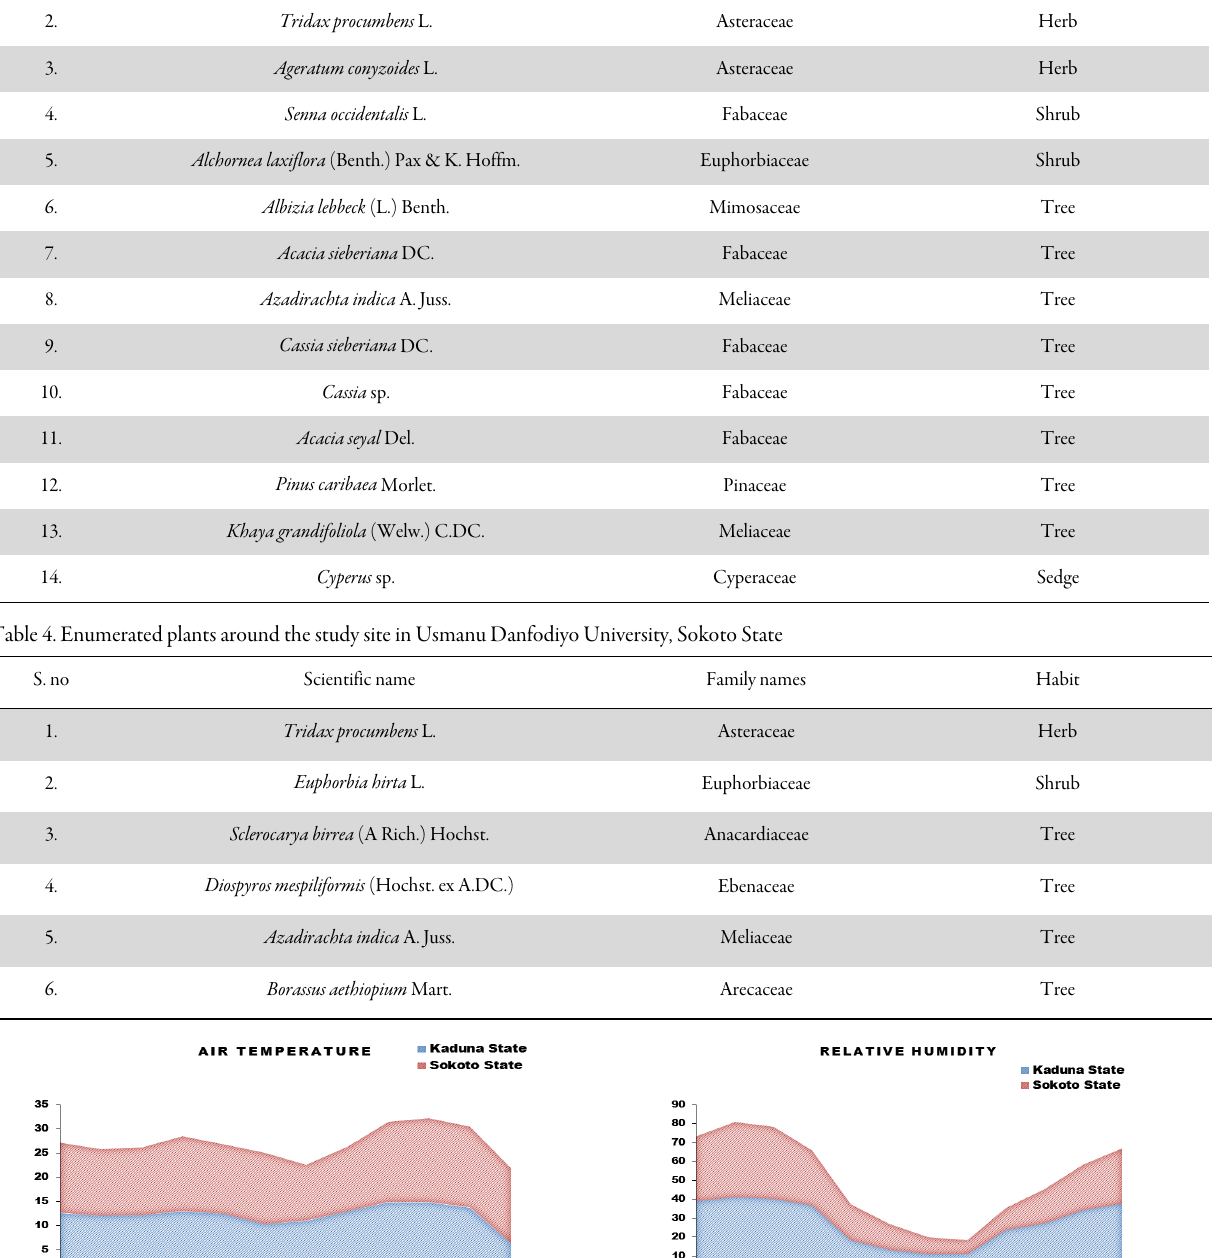
Table 3. Enumerated plants around the study site in Ahmadu Bello University, Kaduna State S. no